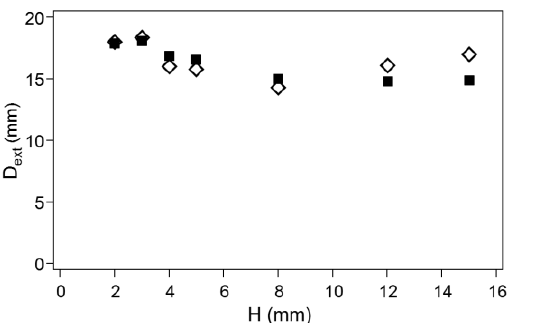
Fig. 4. D Ext as a function of cell opening H. ■ correspond to individual growth experiments at end time, ◊ calculated using the geometric spherical approach proposed by Lin et al [20].